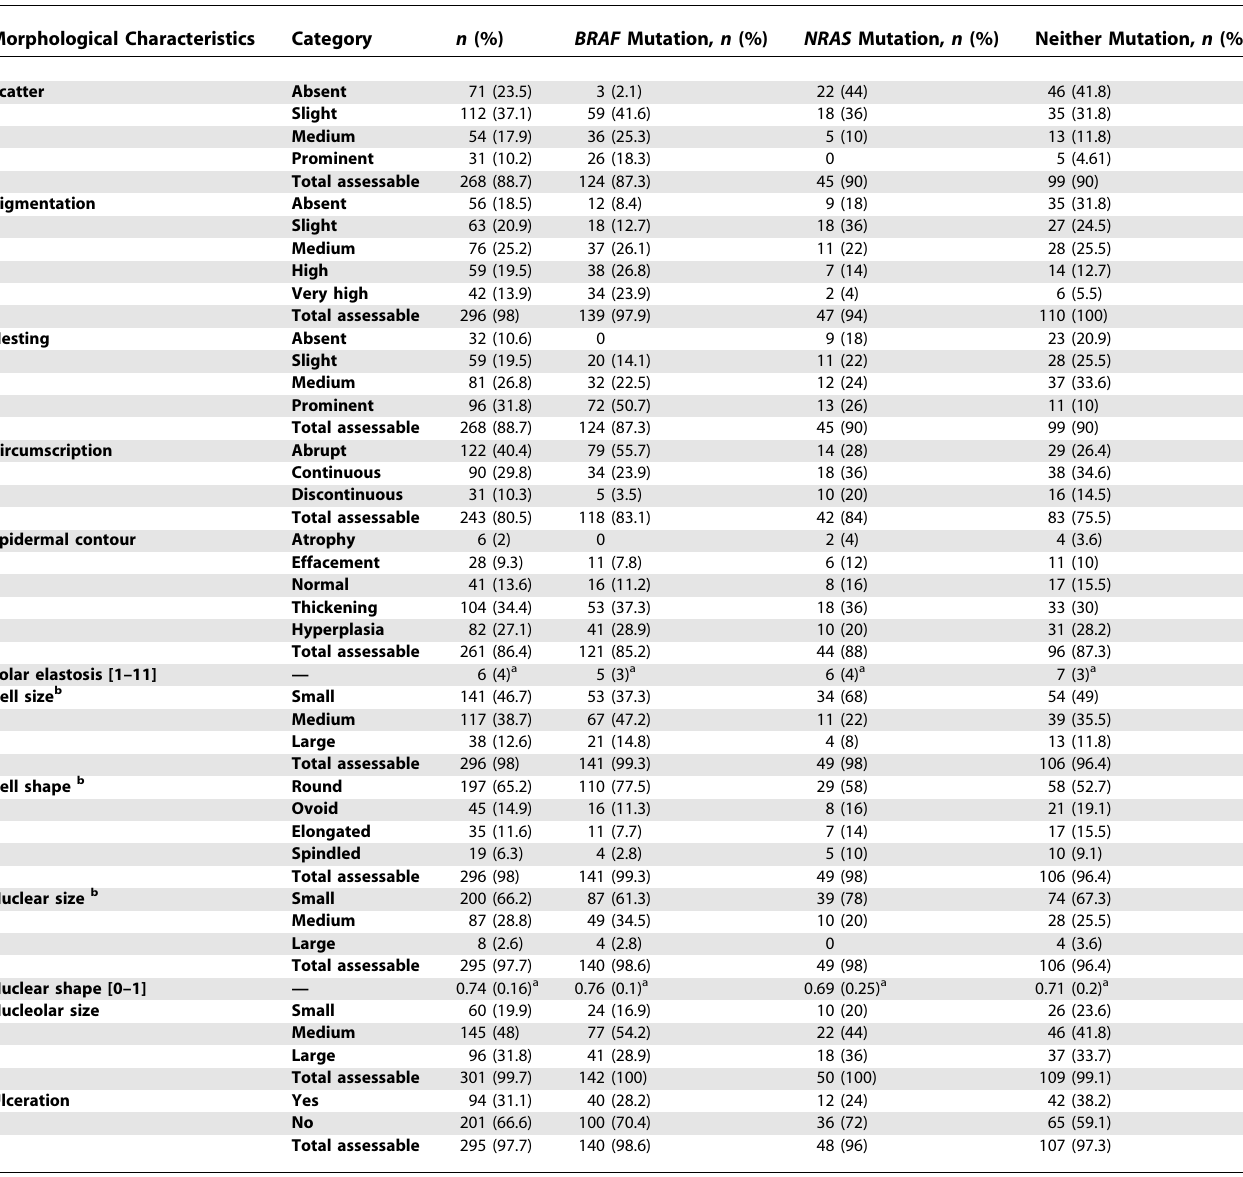
Table 2. Morphologic Features of Melanomas by Mutation Status of BRAF and NRAS Included in Our Analysis Morphological Characteristics Category n (%) BRAF Mutation, n (%) NRAS Mutation, n (%) Neither Mutation, n (%)